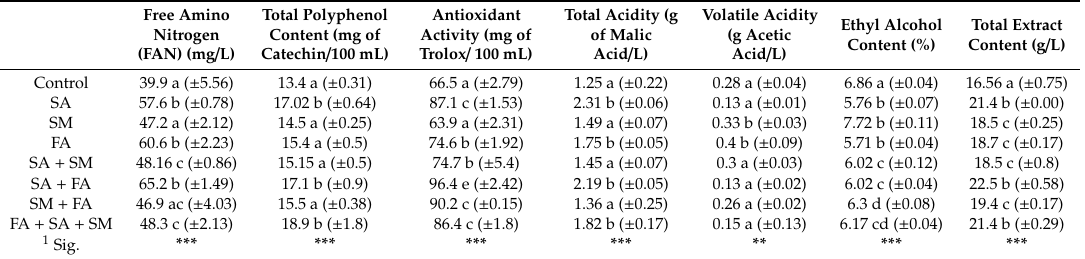
Table 5. Physicochemical parameters for ciders fermented by wine yeast (W), with the following additions: SA—ammonium sulfate, SM—magnesium sulfate, FA—ammonium phosphate.